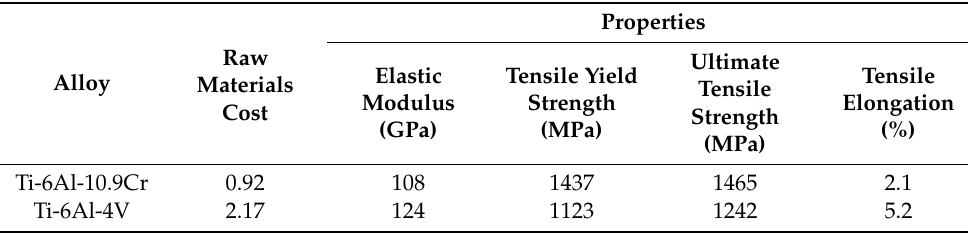
Table 3. Comparison of raw materials costs and properties of Ti-6Al-10.9Cr and Ti-6Al-4V